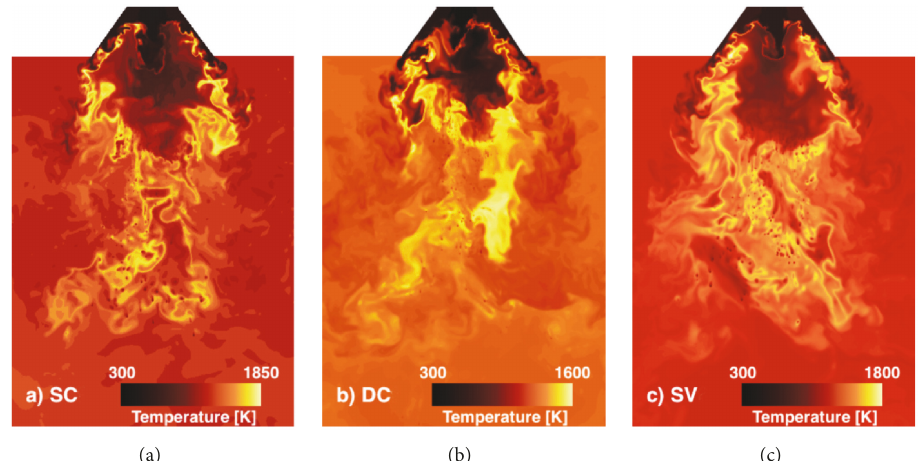
Figure 9: Instantaneous radial mid-plane gas phase temperaturedistribution corresponding to 2.5 seconds of physical runtime, sufficient for the establishment of the gaseous flame. Note that only the region of interest is shown, corresponding to a third of the diameter and half of the length. From left to right: SC, DC, and